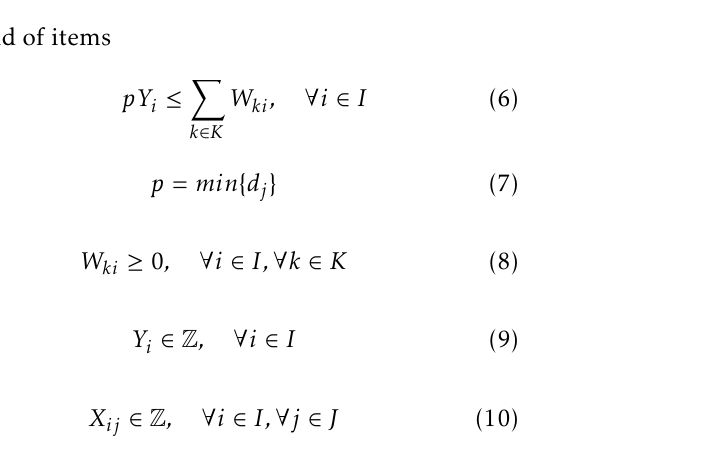
Figure 11. CDC-Factory links.